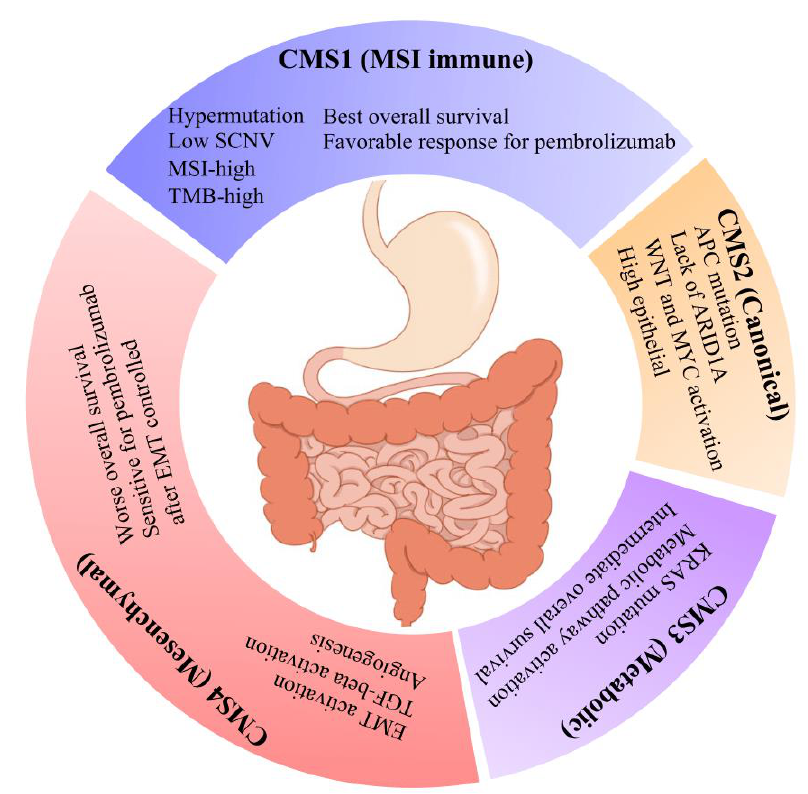
Figure 7. Key characteristics of GAC CMS subtypes. This graphic demonstrates some of the predominant features associated with each of four CMS subtypes of GAC, which are similar to